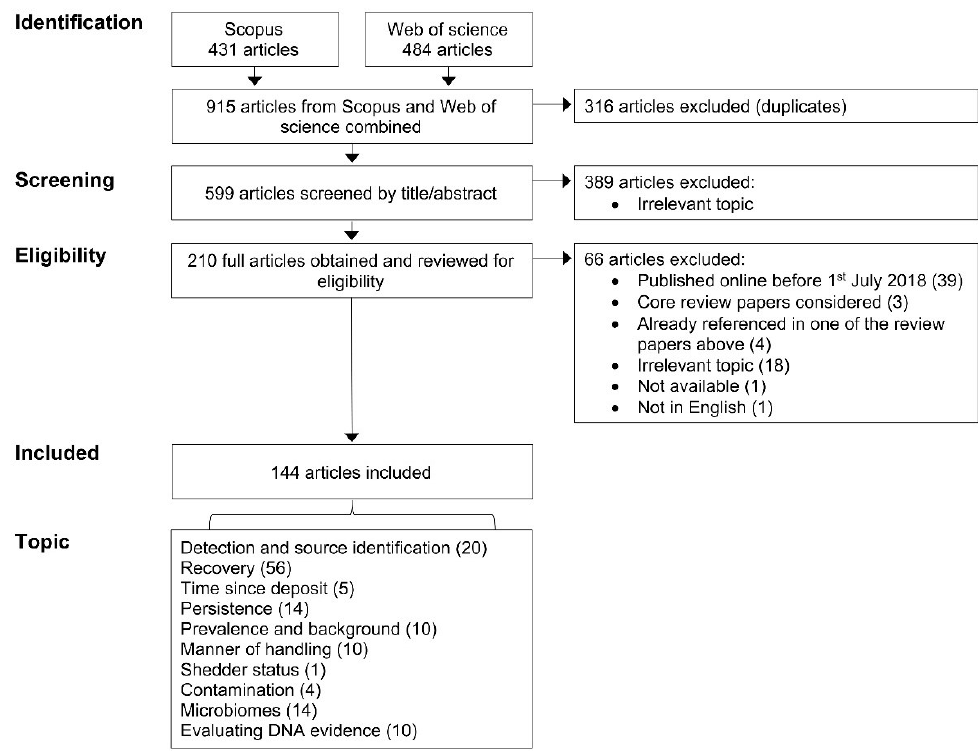
Figure 2. Process and outcome of review to identify articles to be included in synopsis. Topic categorisation of articles was based on their primary area of DNA-TPPR-related focus. Numbers of articles included/excluded are indicated in parentheses after each topic/exclusion criterion.